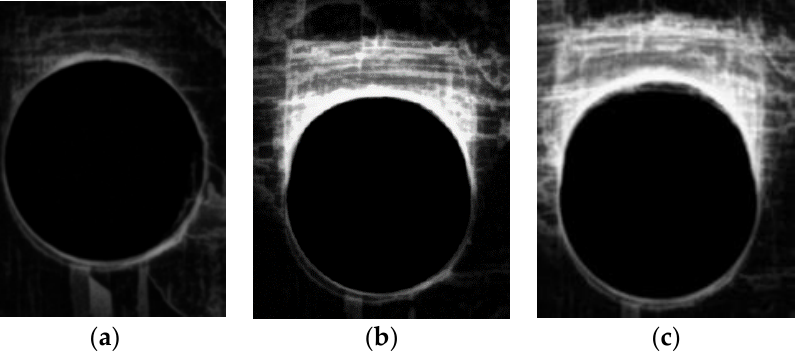
Figure 6. Ovality of drilled holes due to cyclic bearing test—concept.